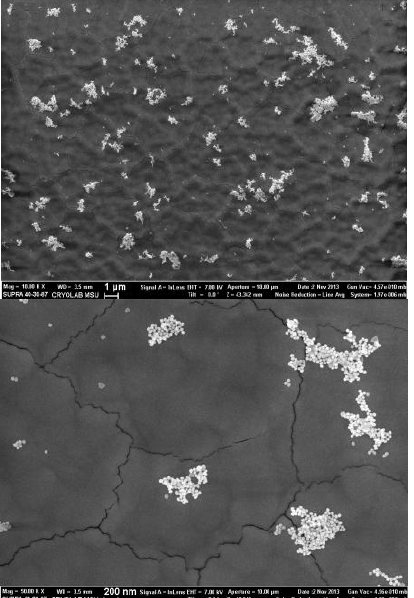
Figure 5: SEM images of facet cerium dioxide films with Au-NP.